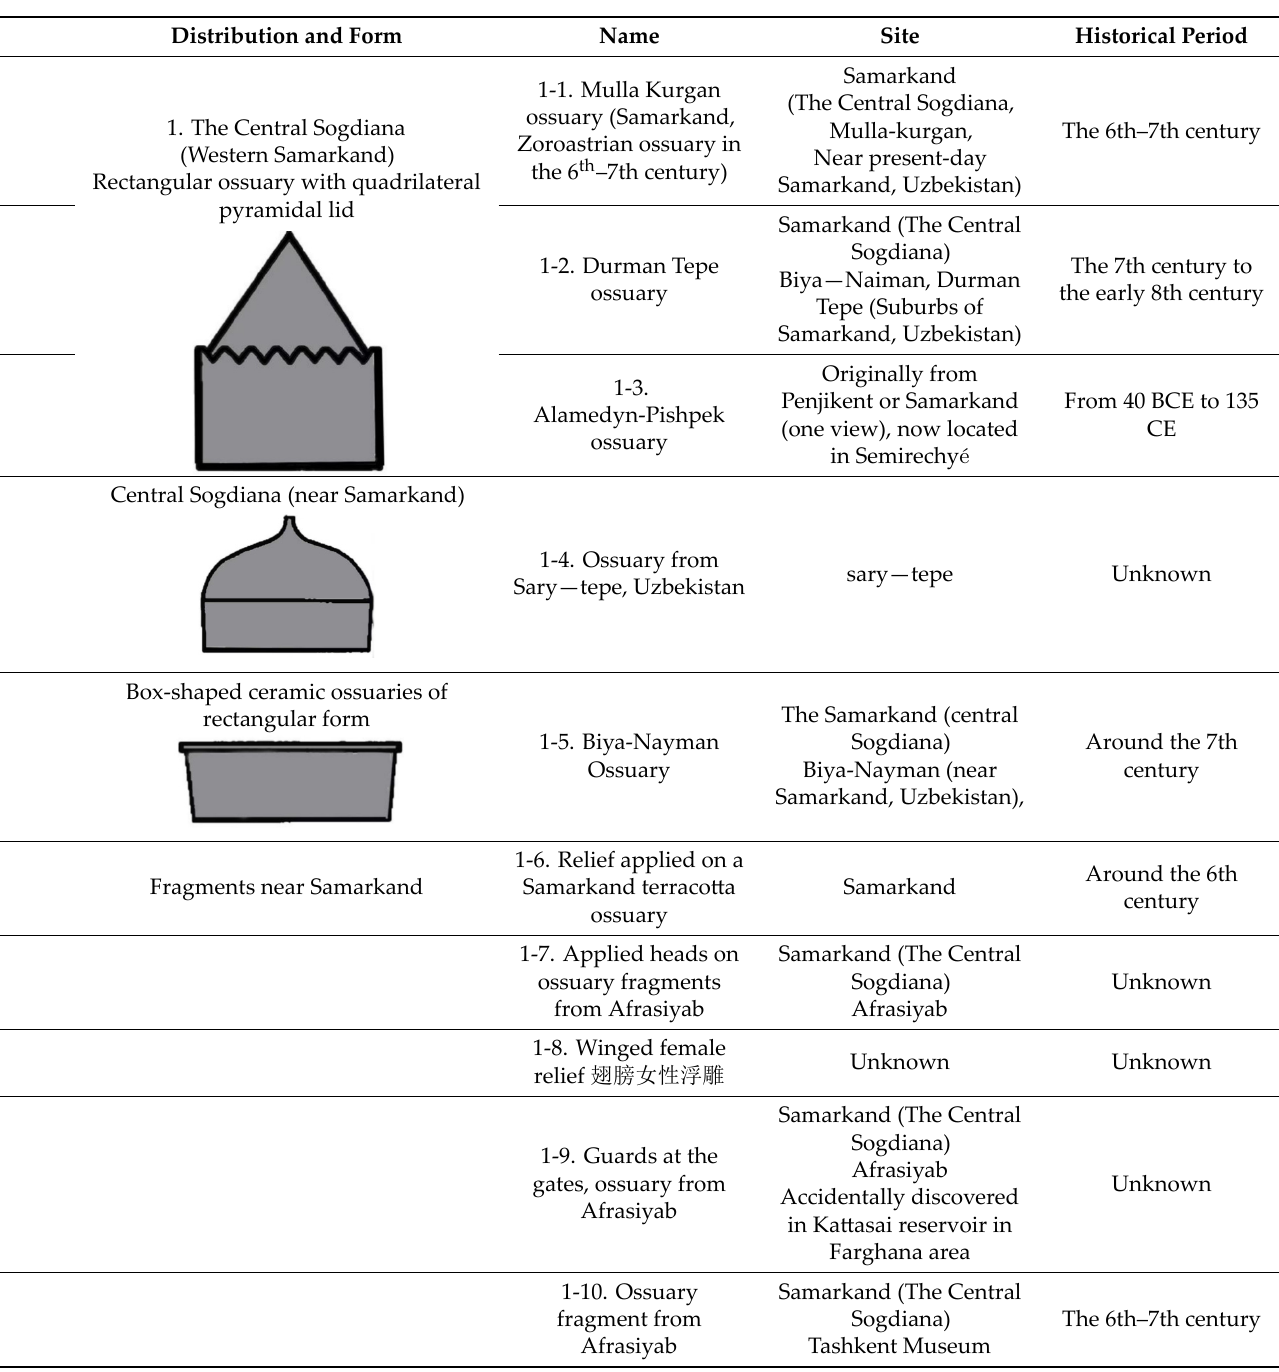
Table 3. The Historical Period and Shape of Sogdian Ossuaries in Central Asia. 2